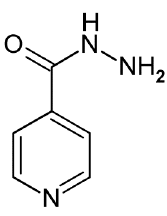
Figure 1. Chemical structure of antituberculotic agent—prodrug isoniazid (INH). The observed resistance of MTb to INH arises from mutations in the mycobacterial KatG and its reduced ability to activate the prodrug